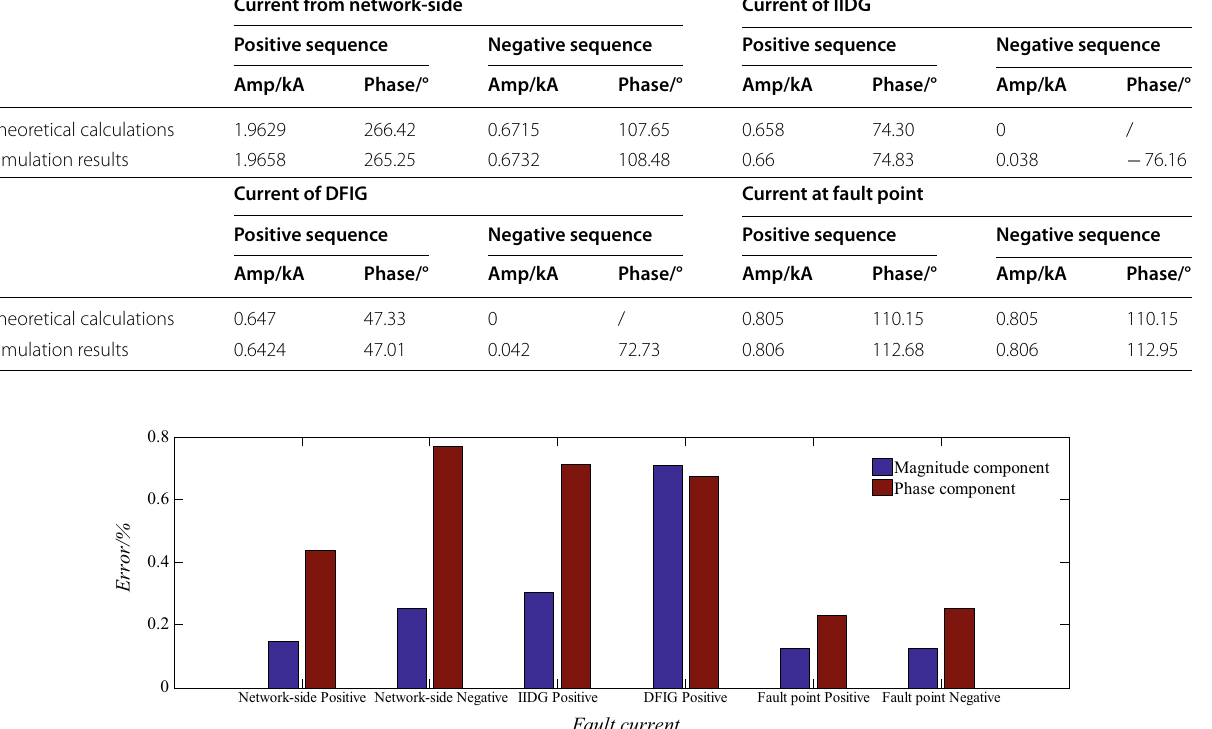
Fig. 10 Error comparison of current calculations/simulations under an asymmetrical